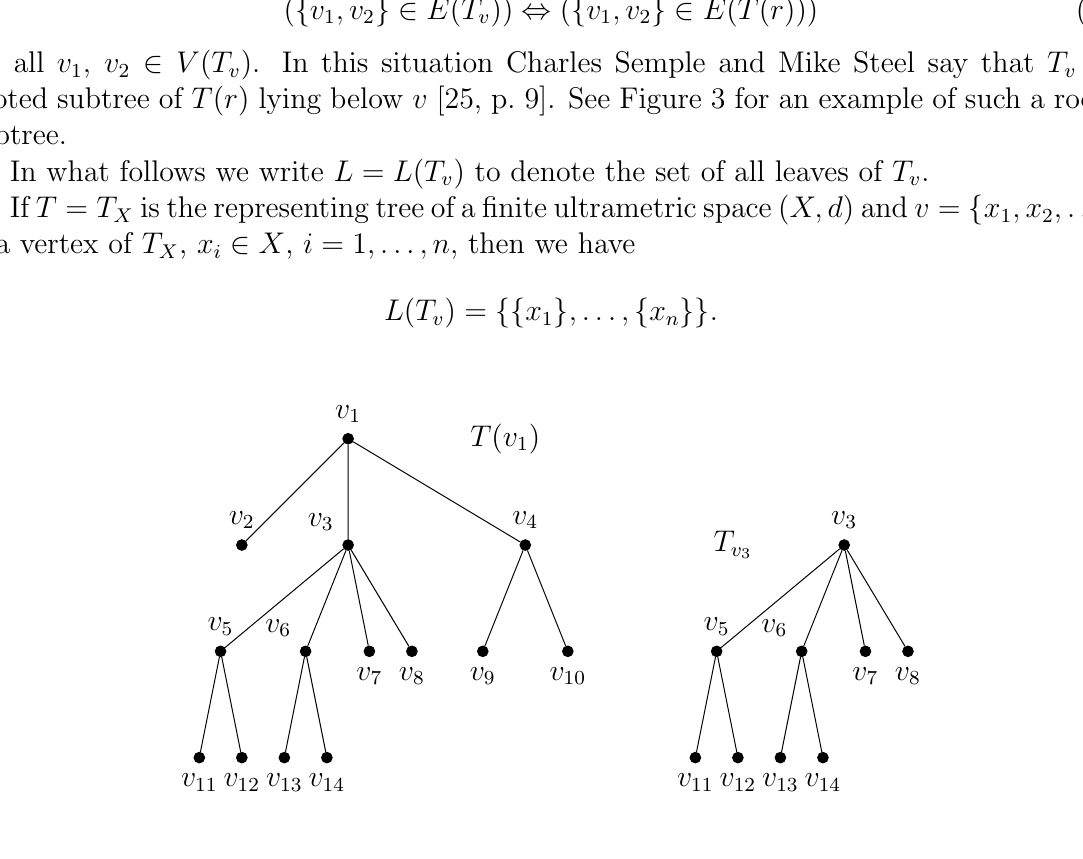
) lying below v 1